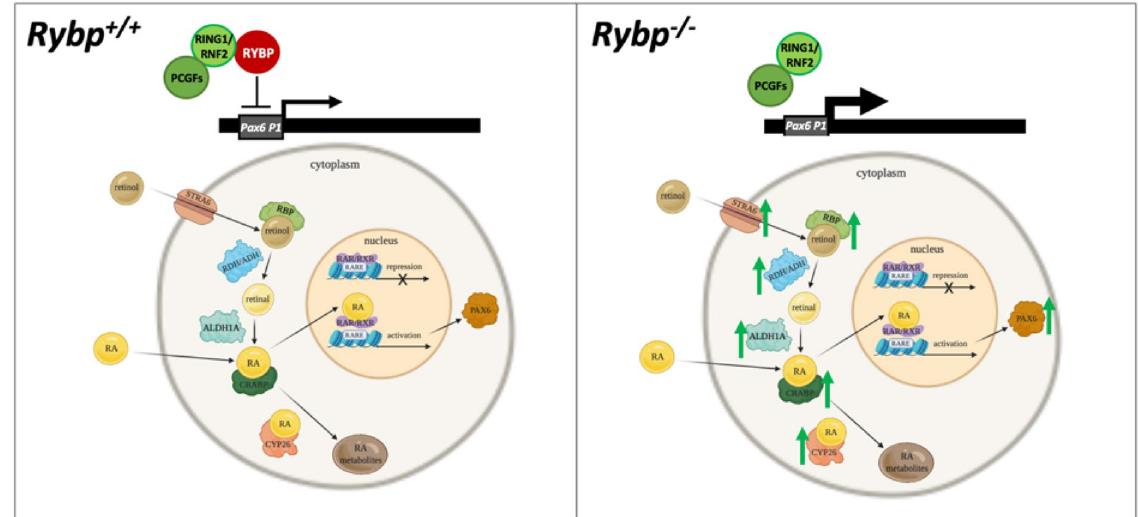
Figure 8. RYBP directs neurogenesis through the regulation of RA pathway and Pax6 . In the absence of Rybp the mRNA expression of the RA pathway members and RYBP target gene Pax6 are upregulated. Normal Rybp level is required to the normal neural differentiation. RYBP can regulate the Pax6 expression via ncPRC1. The green arrows represent the upregulation of the gene expression of the RA pathway